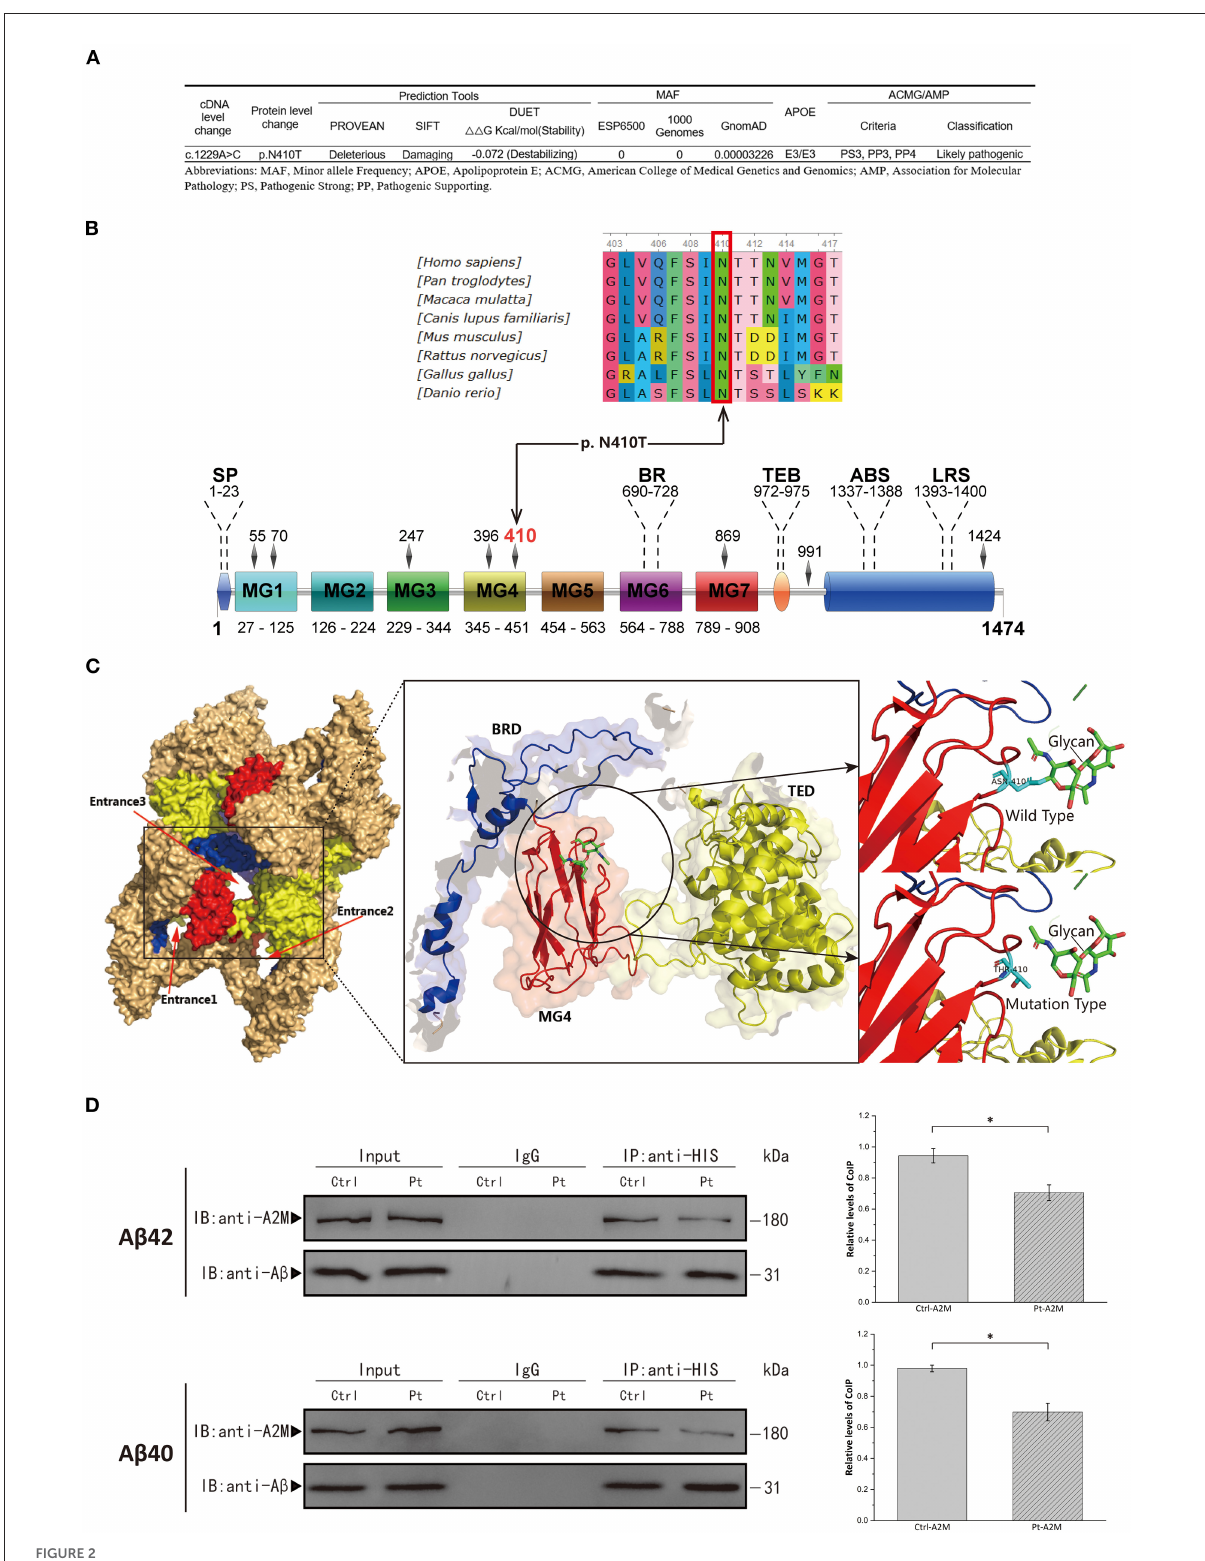
FIGURE2 (A) Schematic of p.Asn410Thr mutation identified in the A2M gene. (B) Upper, conservation analysis of the mutation site. Amino acids marked with red column are highly conserved among all shown species. Lower, schematic representation of the full-length A2M protein; SP,